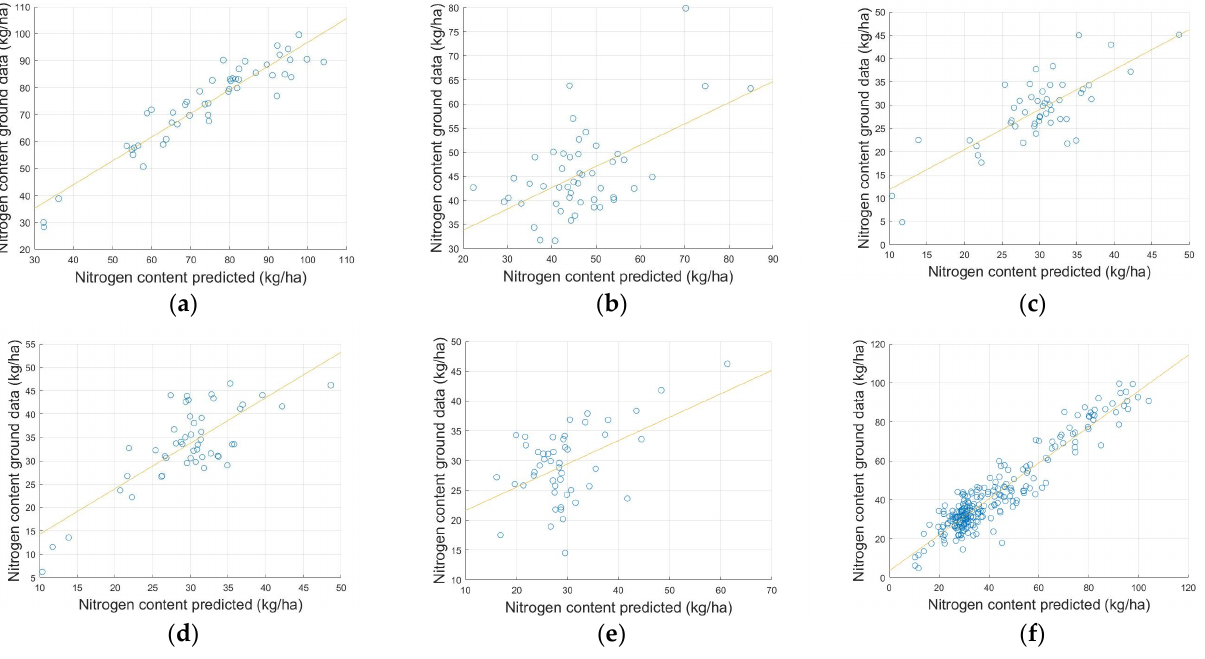
Figure 5. Scatter plots of the predicted nitrogen content against ground data. ( a ) D 1 (R 2 = 0.876), ( b ) D 2 (R 2 = 0.307), ( c ) D 3 (R 2 = 0.601), ( d ) D 4 (R 2 = 0.605), ( e ) D 5 (R 2 = 0.252), ( f ) all data (R 2 = 0.884). ( b ) D 2 = 0.307), ( c ) D 2 = 0.601), ( d ) D 2 = 0.605), ( e ) D 2 = 0.252), ( f ) all data (R 2 = 2 (R 3 (R 4 (R 5 (R